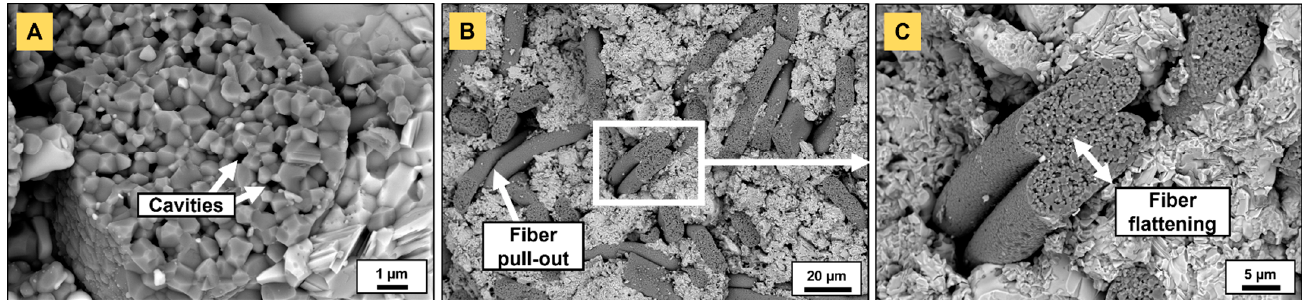
Figure 11. Fracture surface of a Ti 2 AlC nut reinforced with 20 vol.% N720 fibers: ( A ) submicrometric pores arising from mullite decomposition, ( B ) partial fiber pullout observed at ( C ) higher magnification with fiber flattening.